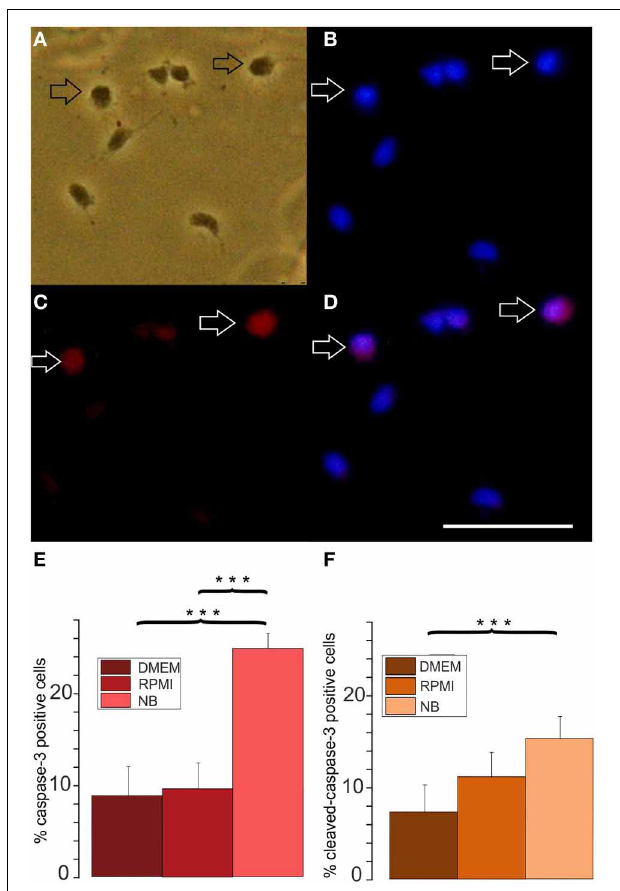
FIGURE 4 | Effects of different basal culture media on caspase-3 immunopositivity. (A–D) Examples of a caspase-3 stained culture: (A) phase contrast picture, (B) Hoechst 33258 staining of the same image, (C) caspase-3 immunofluorescence, (D) merged pictures (B) and (C) , calibration bar indicates 50 μ m. Cells stained after culture in proliferation medium based on DMEM for 3 days (E) percentage of caspase-3 positive cells and (F) cleaved caspase-3 positive cells after 3 days of culture in NB, DMEM as well as RPMI based media, (8 coverslips from 5 preparations evaluated, ∗∗∗ p < 0 . 005; error bars indicate ± s.e.m.).